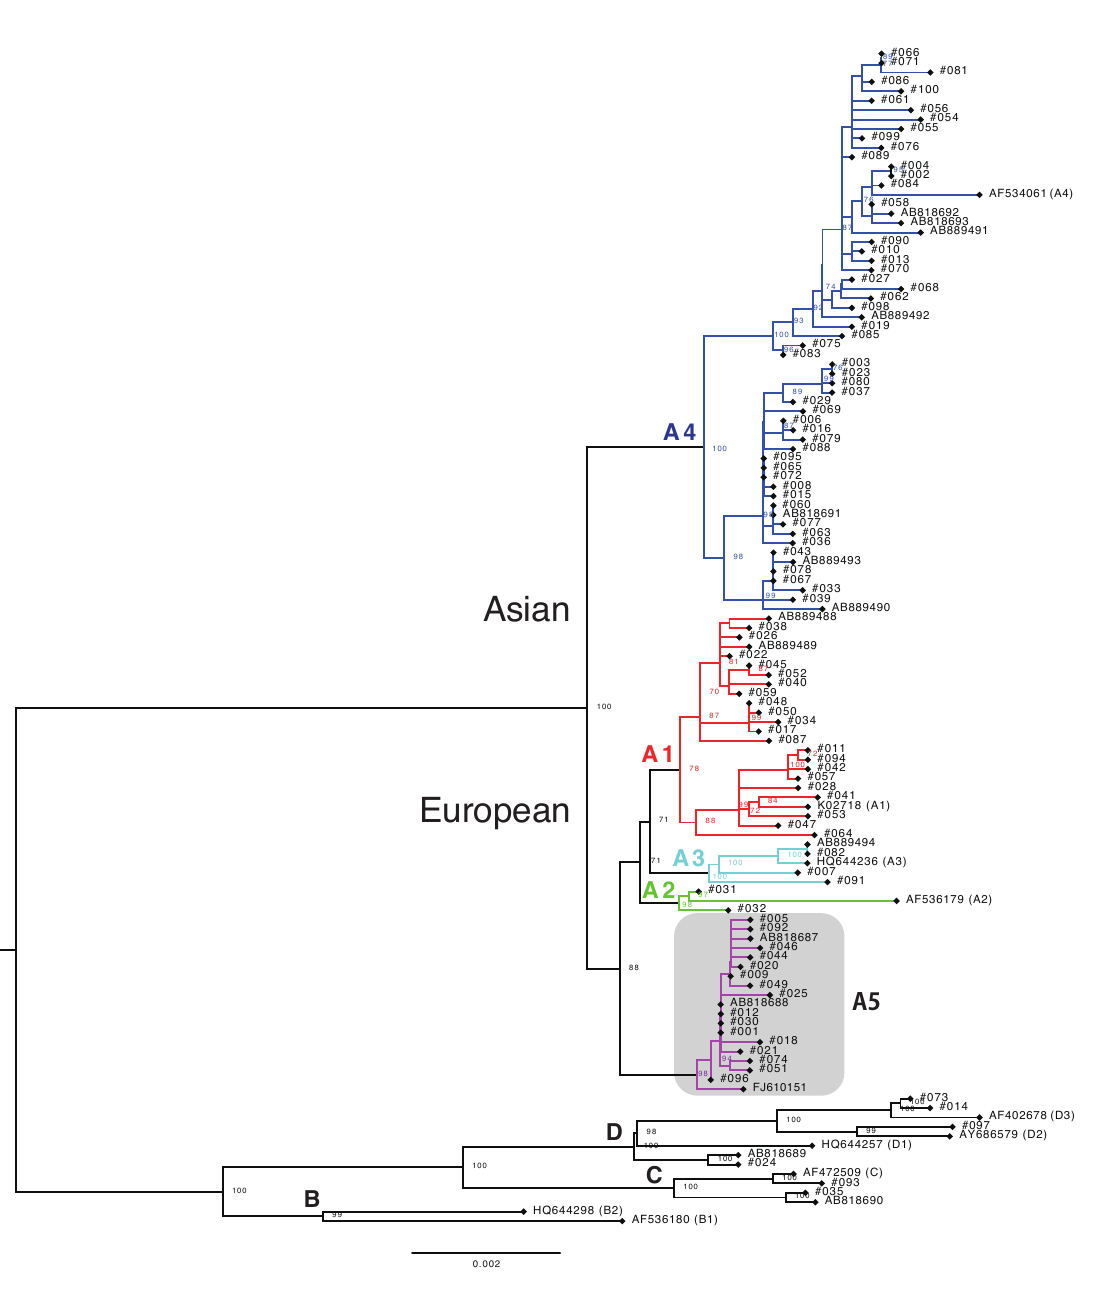
Figure 1. Maximum likelihood phylogenetic tree of Japanese HPV16 isolates. The phylogenetic tree was constructed using whole-genome sequences of 100 Japanese isolates obtained in this study, together with those of 14 Japanese isolates previously determined by us, one Thai isolate, and 10 reference strains for HPV16 variant (sub) lineages. Bootstrap values larger than 70% are displayed. Scale bar, nucleotide substitutions per site. A1, A2, A3, and A4: sublineages; B, C, and D: lineages. Gray area indicates a cluster of A5